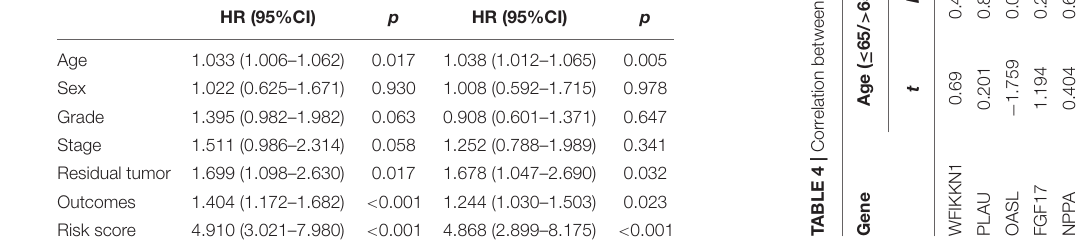
TABLE 3 | Univariate and multivariate independent prognostic analyses.